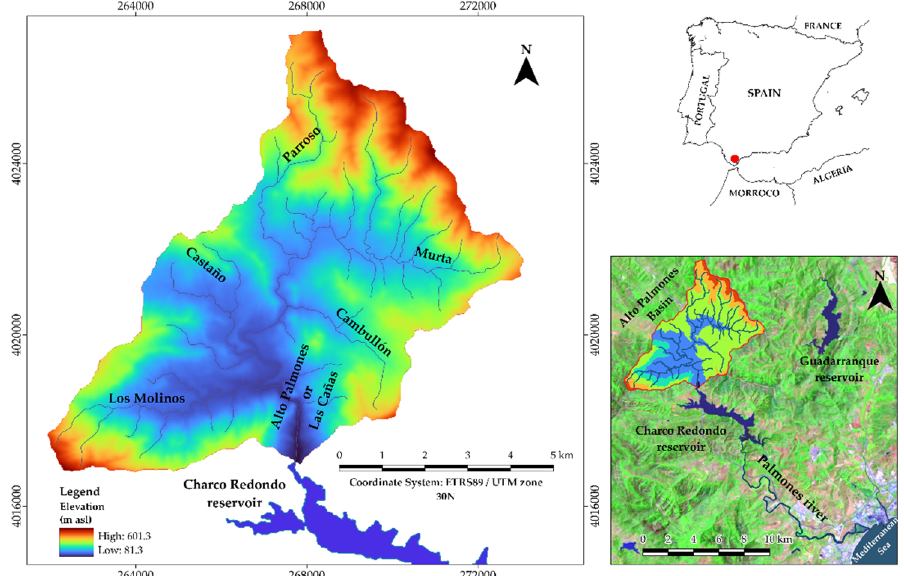
Figure 1. Location of the Alto Palmones basin.